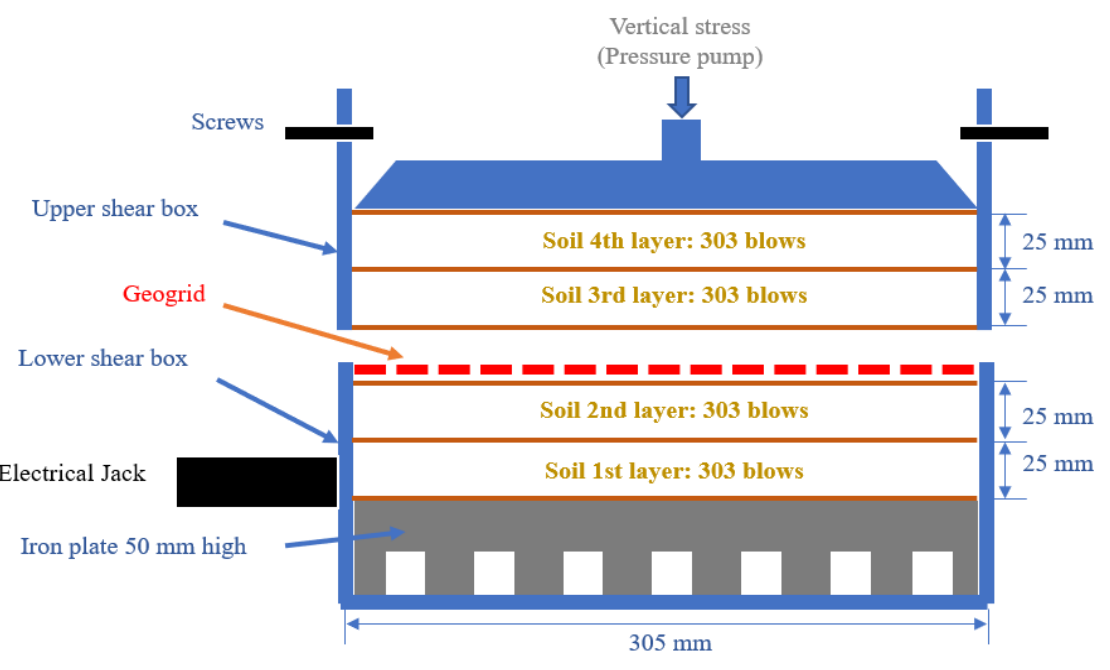
Figure 7. Large - scale direct shear apparatus: ( a ) large - scale direct shear apparatus; ( b ) shear box.